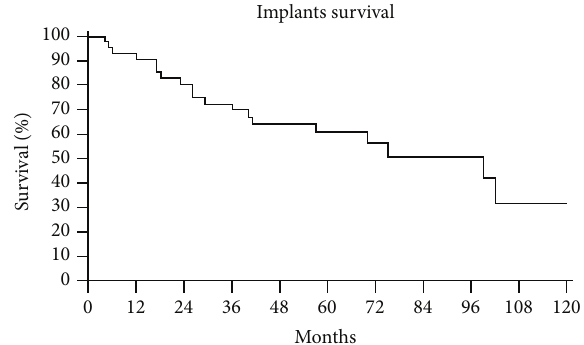
Figure 8: Nonunion of the anterior pelvic ring in a P2 resection and reconstruction with